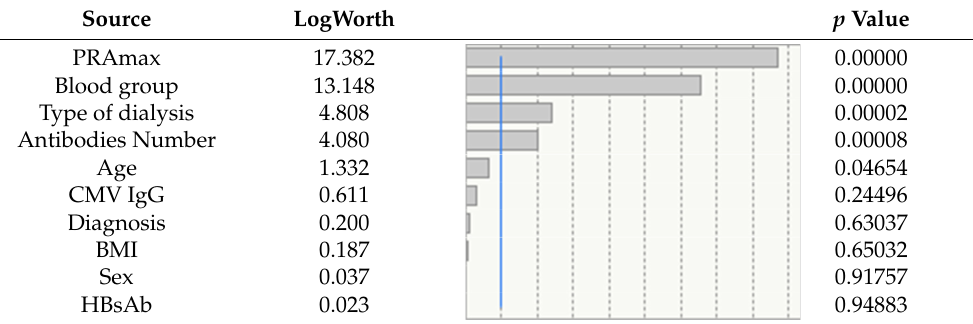
Table 2. Multiple regression for Time to transplant.